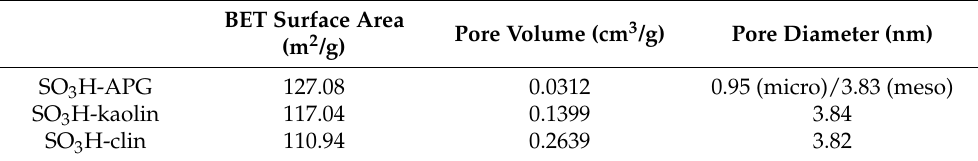
Table 2. Physical properties of SO 3 H-APG, SO 3 H-kaolin, and SO 3 H-clin